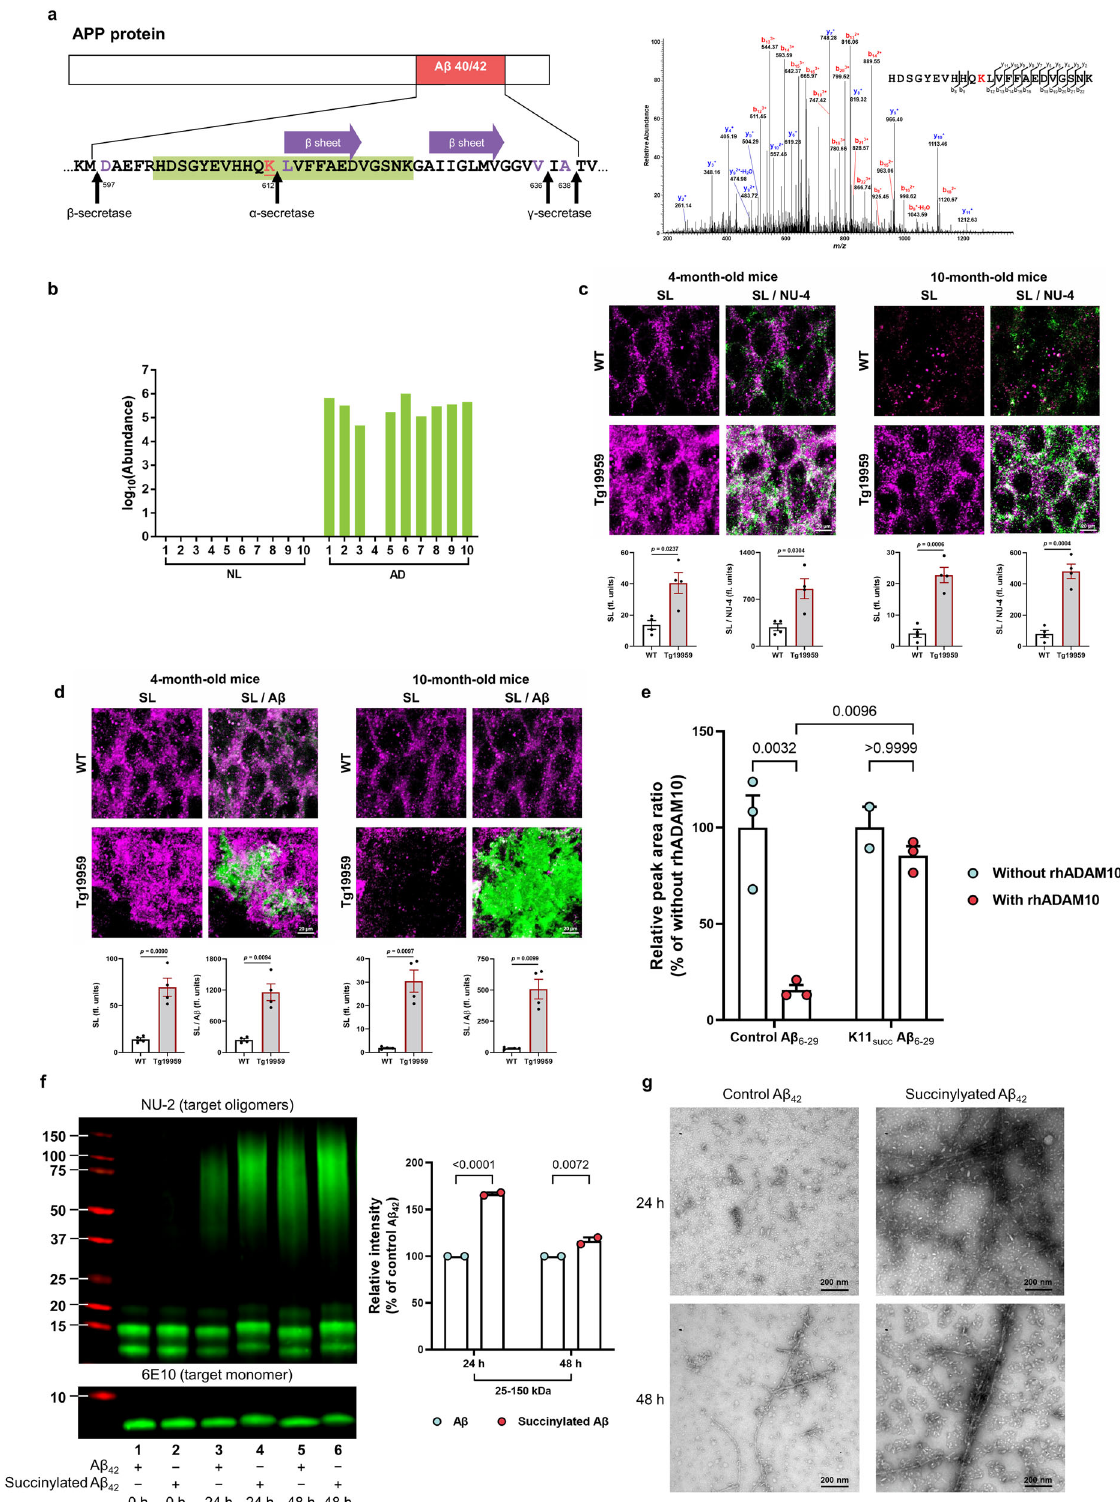
(Fig. 7i). These results indicate that succinylation of K19